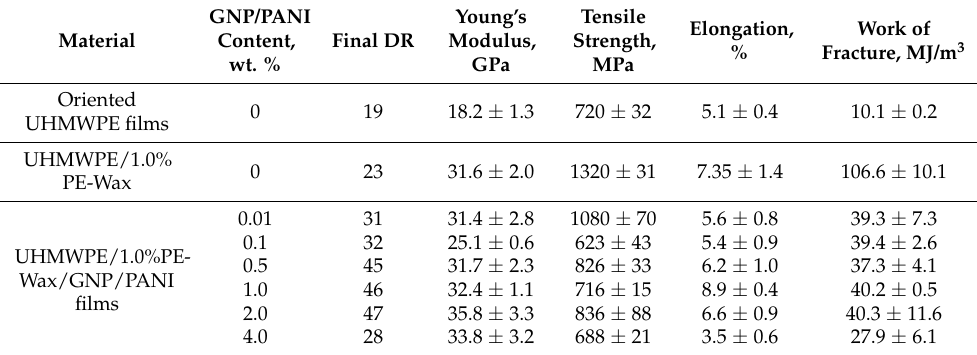
Table 3. Mechanical tensile properties of the UHMWPE/PE-wax/GNP/PANI films with different GNP/PANI content obtained by first thermal orientation regime ( ± the standard deviation).